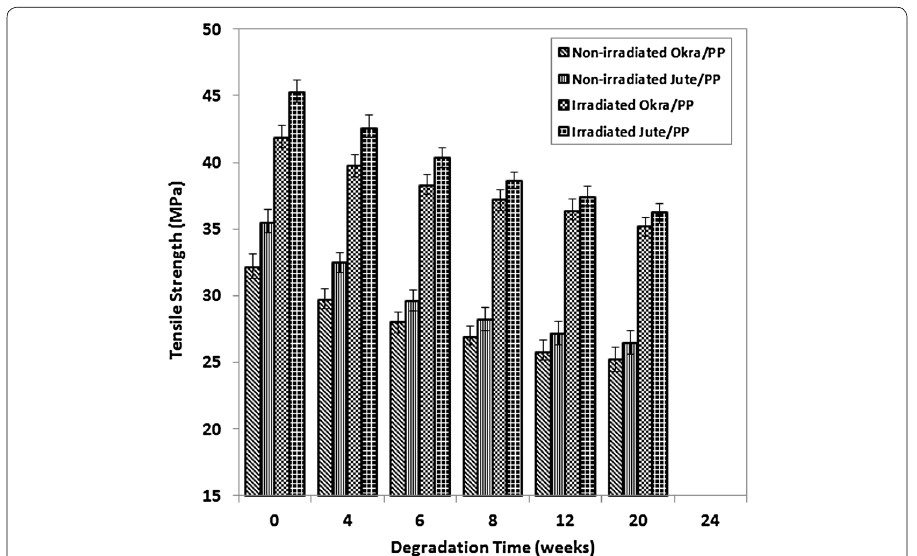
Fig. 11 Degradation of tensile strength of non-irradiated and irradiated (500 krad) composites under soil